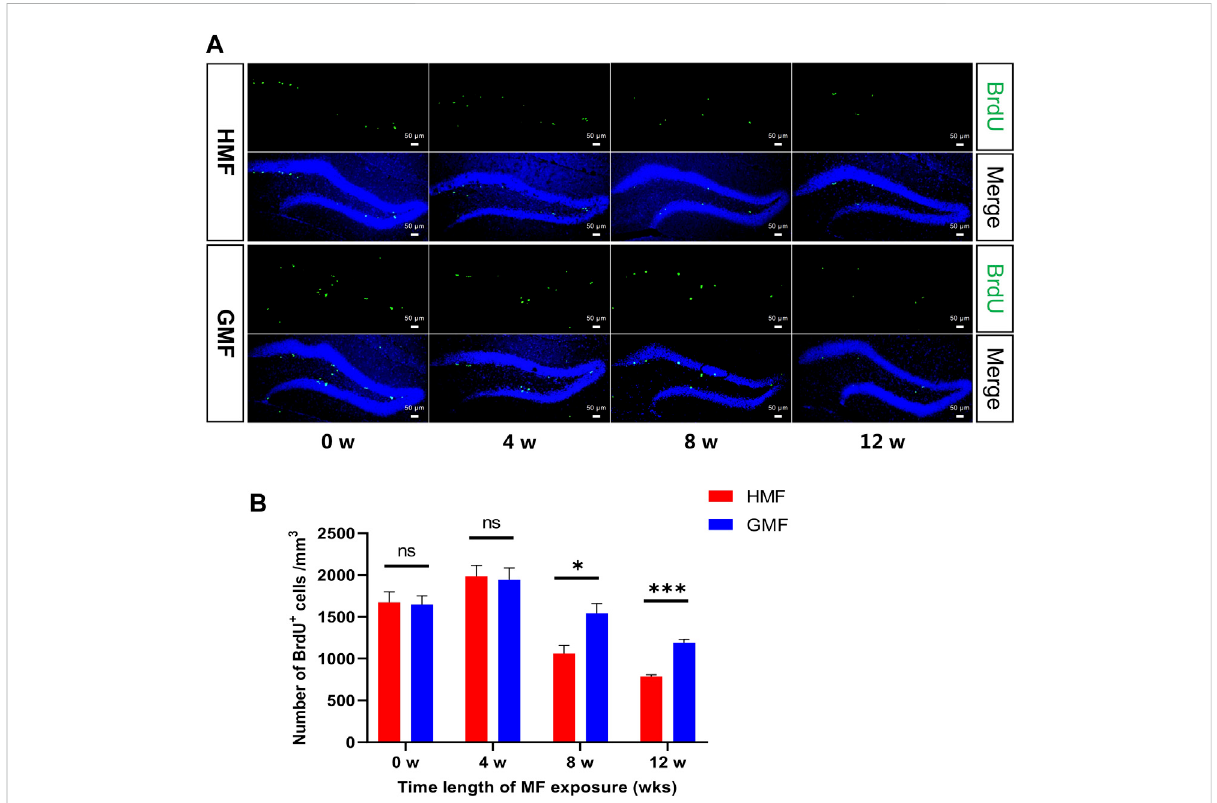
FIGURE 2 The 8-, and 12-week hypomagnetic fi eld (HMF) exposure signi fi cantly decreased the proliferation of aNSCs in DG of hippocampus. (A) Representative imagesofBrdU + cells intheDGat0-,4-, 8-, and 12-week ofGMF-or HMF-exposure. (B) Quanti fi cationofnumbersofBrdU +